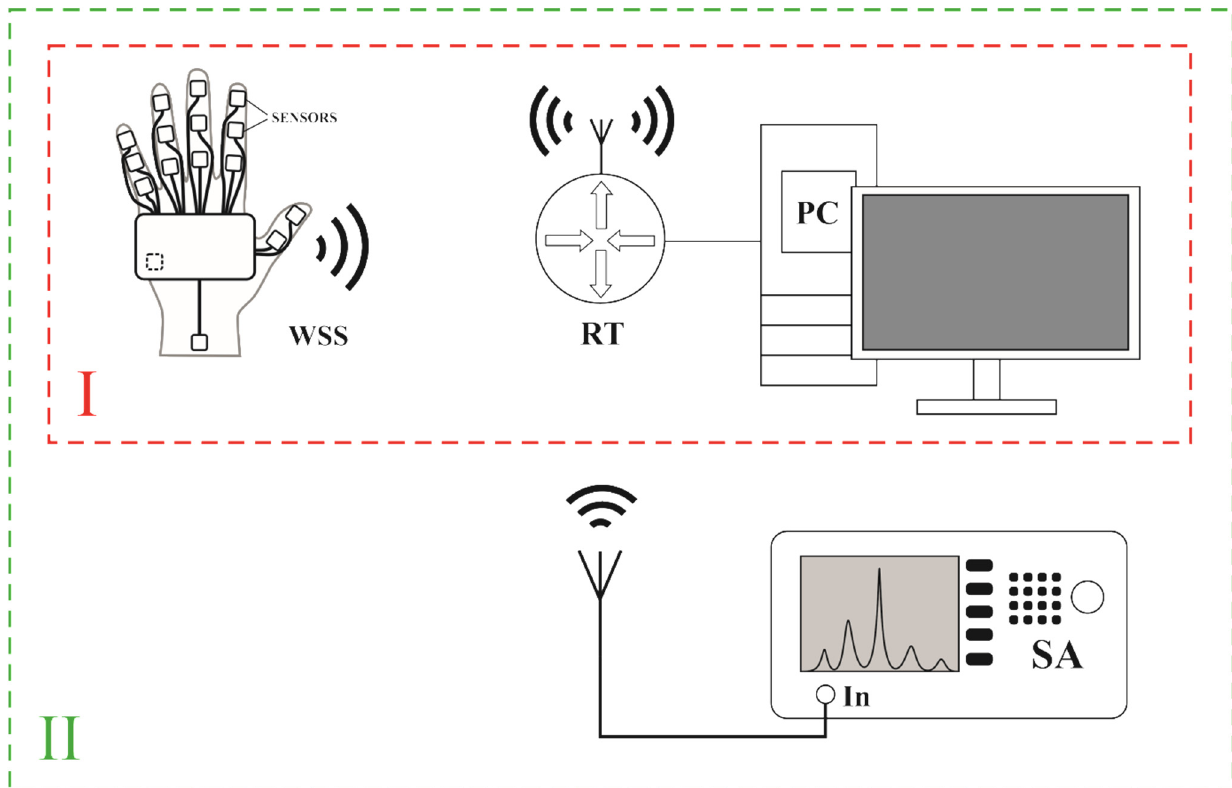
Figure 1. Station for measuring the network band occupancy.